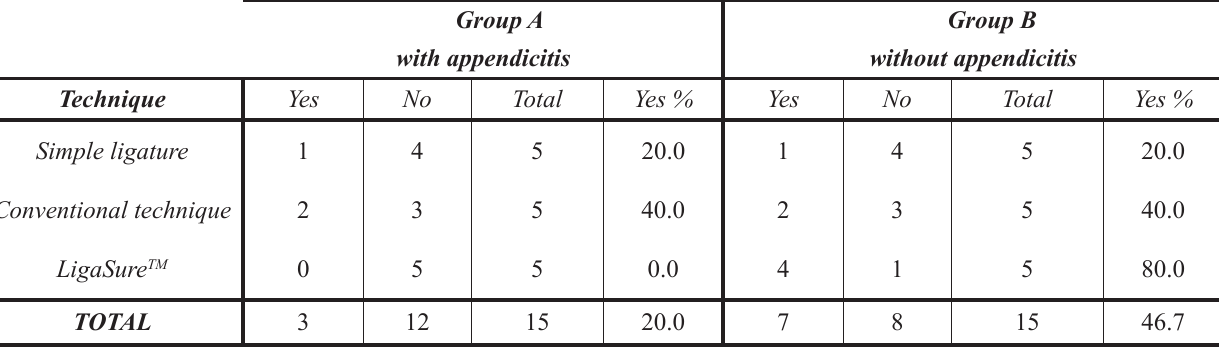
TABLE 3 - Rabbits from groups A and B in the three operative techniques for intracavitary